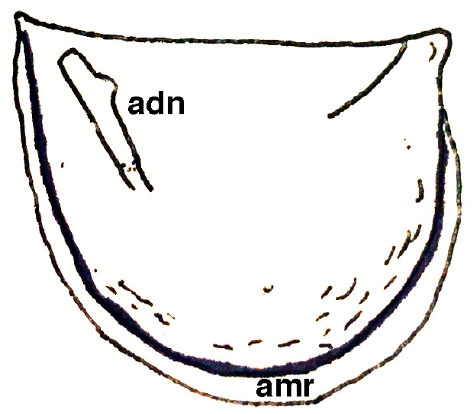
Figure 26. Parahoulongdonella bashanensis . Anterior to left. Scale bar 200 microns. Abbreviations: adn , anterodorsal node; amr , admarginal rim. Image Credit: Mark